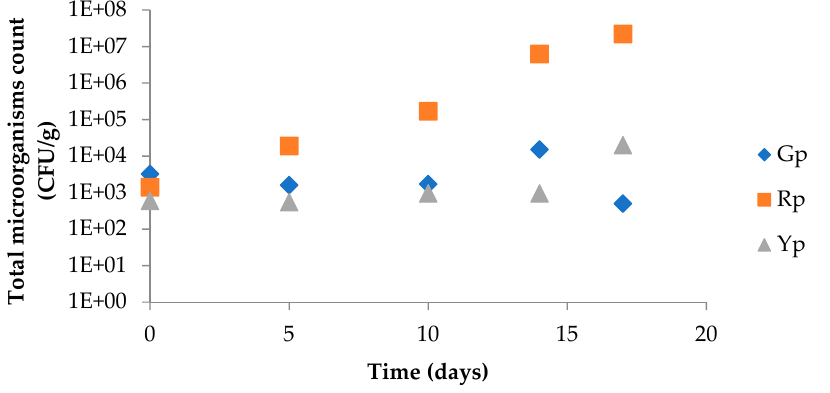
Figure 5. Total microorganisms count (log CFU g − 1 ) at 30 °C of fresh-cut bell peppers (green pepper; red pepper; yellow pepper) stored under an initial MAP condition of 10% O 2 and 45% CO 2 throughout 17 days at 5 °C.